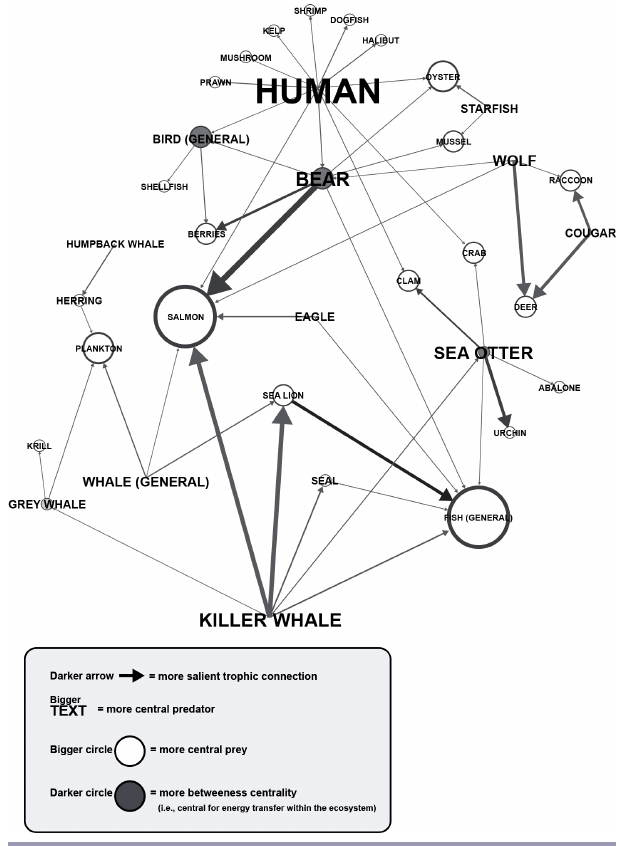
Fig. 6 . Aggregate mental model of the regional food web: non- First Nations. For non-First Nations, the most salient aspects of the food web appear to be the predation habits of bears, killer whales, wolves, and cougars, as well as those of sea otters and sea lions. Humans feature as uniquely prolific predators, but not as particularly salient ones. Salmon, and fish in general, are regarded by non-First Nations as the most widely targeted, and hence central, prey species. However, non-First Nations seem relatively agnostic with respect to what those species in turn themselves eat. As such it is in fact bears, and birds, which emerge as the most central species to the foodweb in terms of energy transfer throughout the ecosystem. This is largely due to the fact that both are regarded as human prey, not true apex predators. Finally, non-First Nations appear somewhat uniquely cognizant of the feeding habits of baleen whales, with clear beliefs about how that whale-driven subsystem connects to the rest of the food web through herring and killer whale predation. (Note that this visualization is demonstrative of the method’s potential uses, not necessarily representative of a demographic with statistically distinct